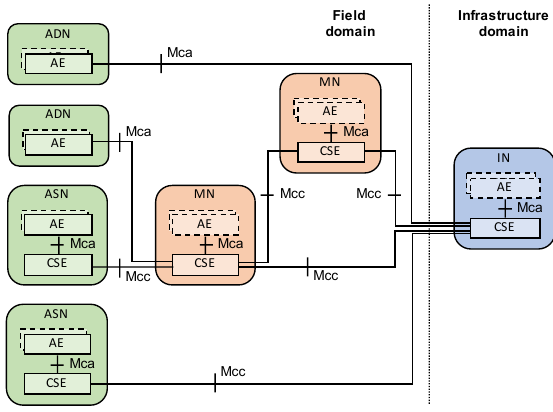
Figure 1. oneM2M functional